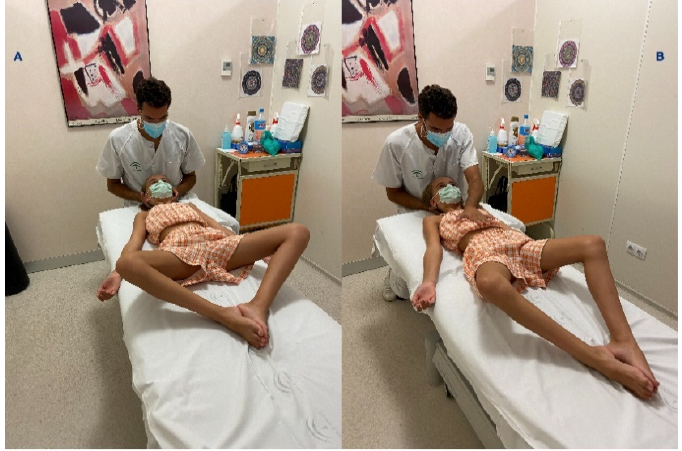
Figure 2. Example of GPR therapeutic management, with patient placed in lying position with lower limbs in closed chain position to increase the tension of the psoas muscles while asked to perform paradoxical breathing and spine corrections ( A ). The posture will evolve to reduction in hip flexion ( B